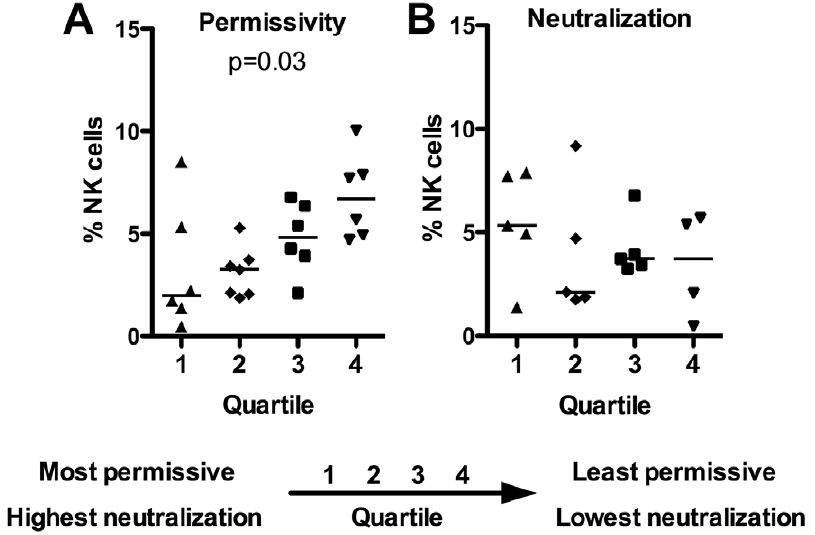
Figure 1. Donors with more NK cells have decreased viral growth. Donors were stratified by viral growth (A, n=25) and neutralization (B, n=19) then separated into quartiles. The percentages of NK cells for each donor were determined from an average of 3 experiments using flow cytometry and plotted based on quartile. The bars represent median. The Kruskal-Wallis test was used to determine statistical significance.